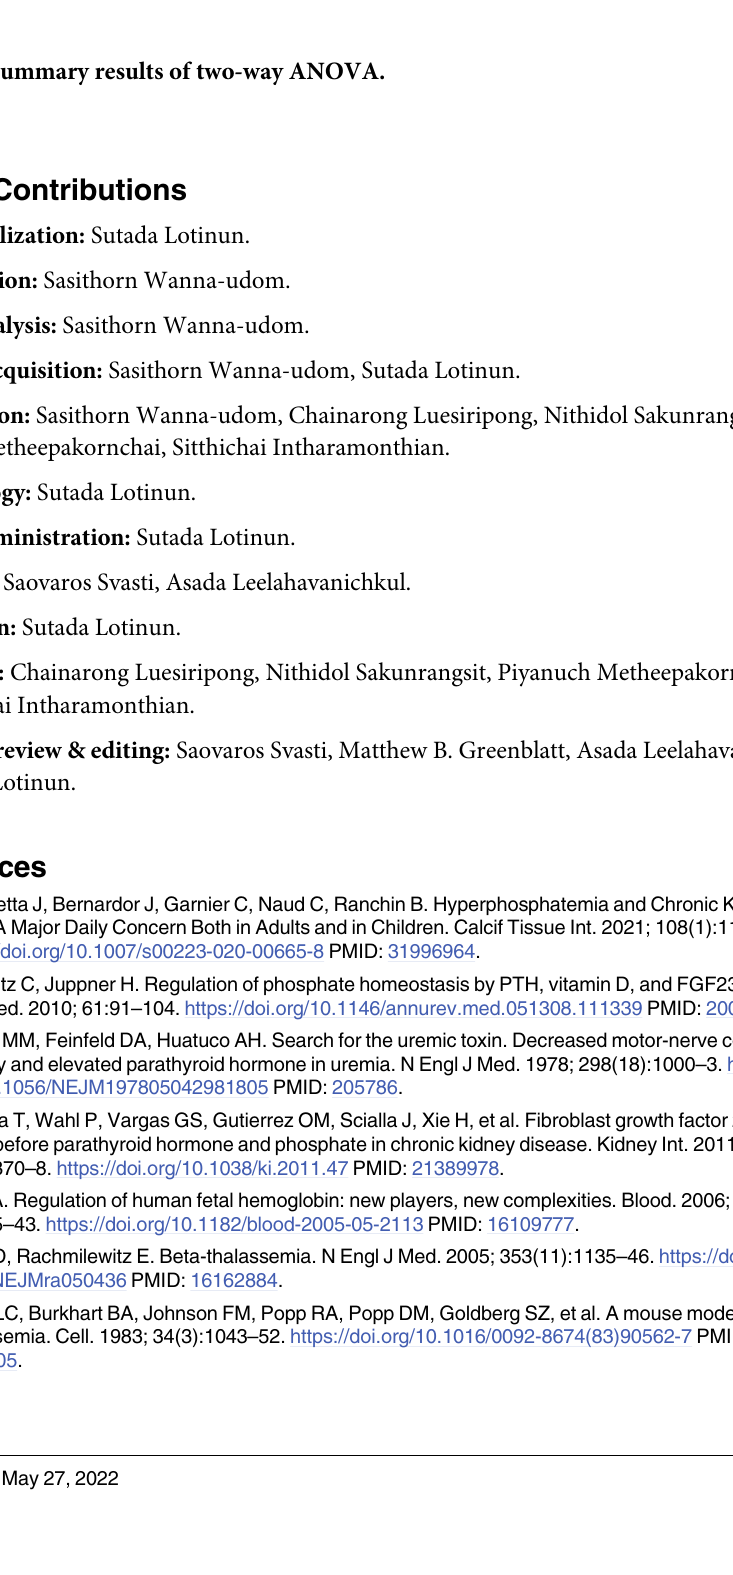
S4 Table. Histomorphometric analysis of BKO and WT controls with nephrectomy and PBS in femurs. S5 Table. Summary results of two-way